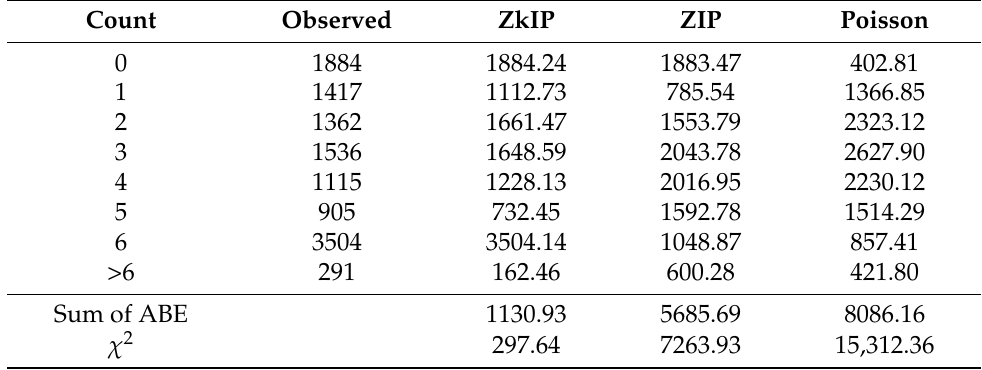
Table 5. Frequency comparisons for pap smear